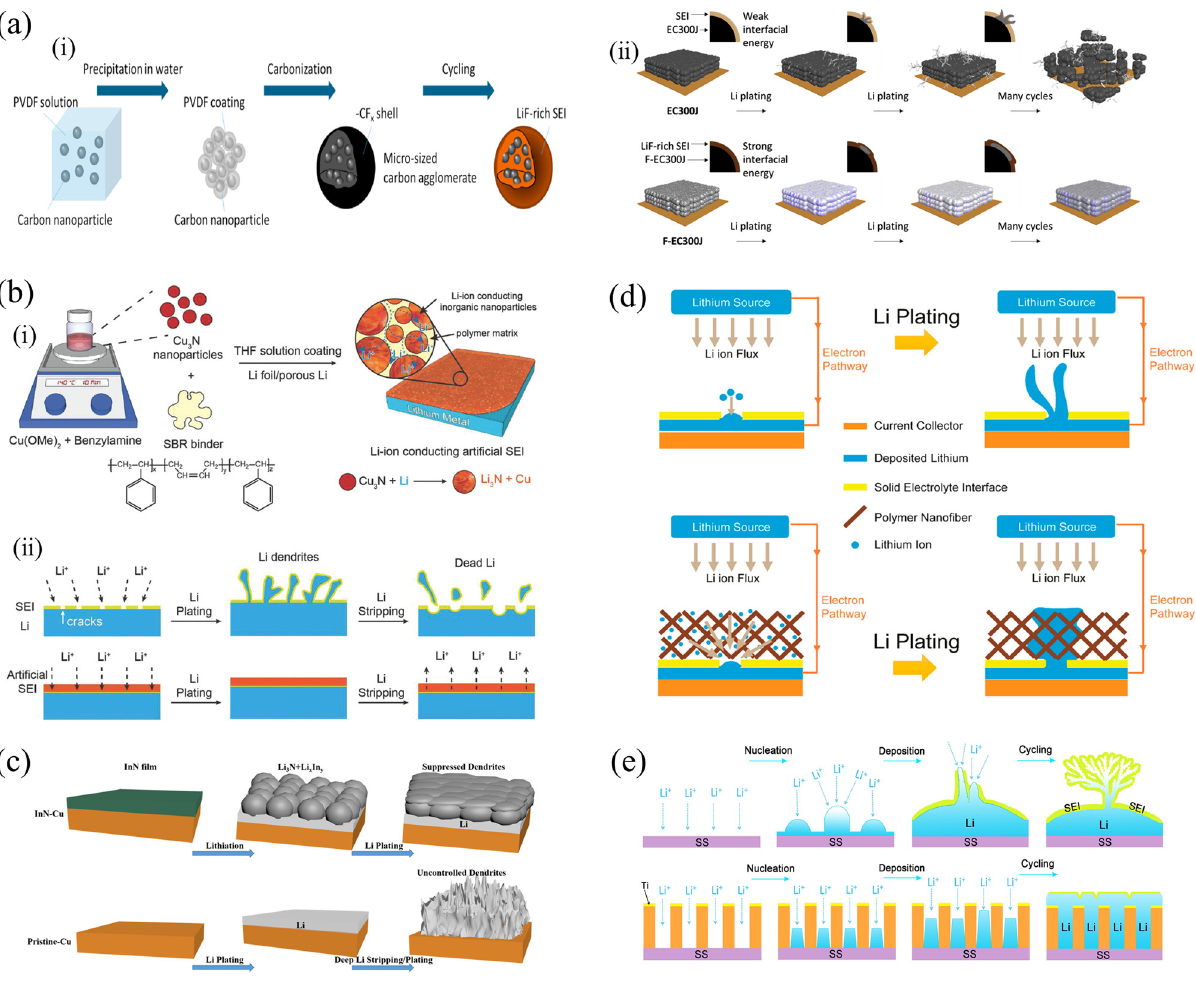
Figure 8: Schematic diagrams: ( a ) the synthesis and structure of – CF x bonded carbon nanoparticles ( F - EC300J ) : ( i ) and Li deposition accommodated in the EC300J, ( ii ) F - EC300J laminates, reprinted with permission from ref. [ 96 ] ; ( b ) ( i ) the fabrication of the Cu 3 N + SBR composite arti fi cial SEI, ( ii ) the Li - plating/stripping behavior of bare Li, the arti fi cial SEI - protected Li, reprinted with permission from ref. [ 101 ] ; ( c ) the In N fi lm in situ converted into the mixed lithium metal protective layer, reprinted with permission from ref. [ 102 ] ; ( d ) the lithium deposition on bare Cu electrode and modi fi ed Cu electrode, reprinted with permission from ref. [ 108 ] ; ( e ) the lithium deposition on bare electrode and modi fi ed stainless steel ( SS ) electrode coated with a nano - channel layer, reprinted with permission from ref. [ 109 ]